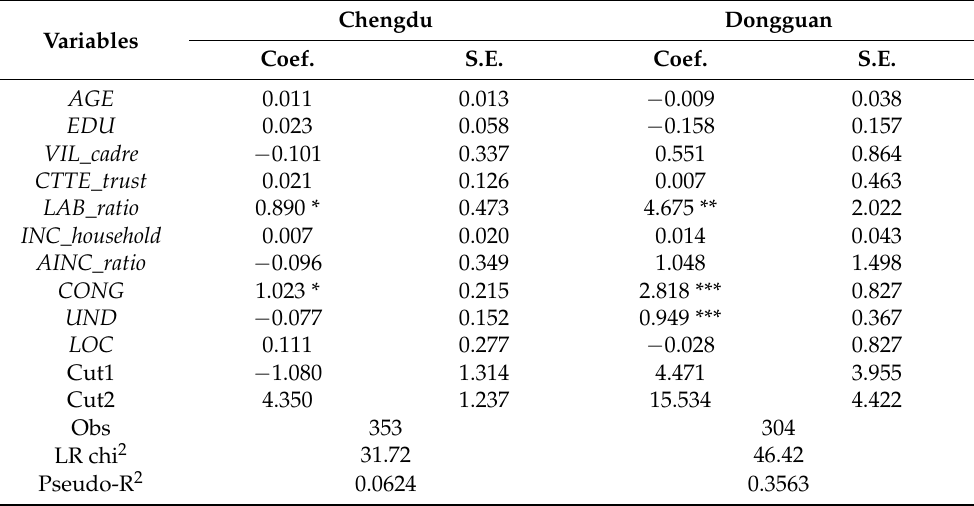
Table 10. Results of Ologit regression.